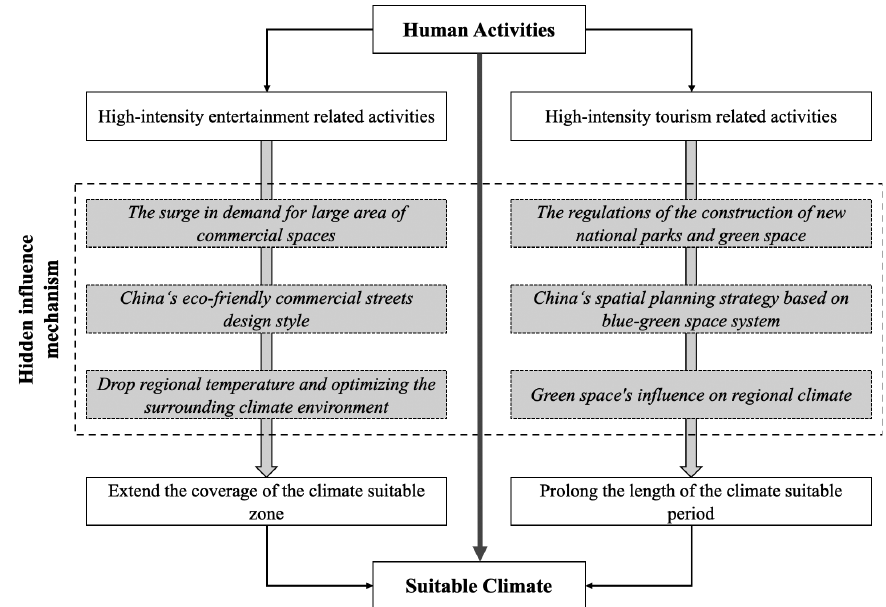
Figure 5. Human activities’ optimization mechanism for climate